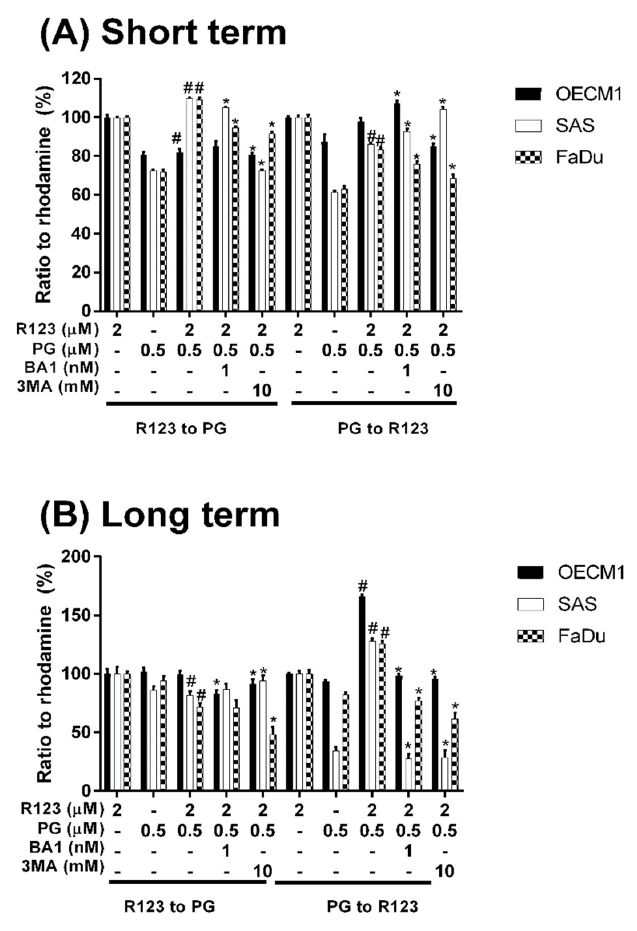
Figure 5. Rhodamine 123 accumulation after PG pretreatment. OSCC cells were treated with PG/R123 for ( A ) short term (1/1 h) and ( B ) long term (12/1 h) followed by analyzed fluorescent intensity within cells. The results were represented as mean ± SD from three individual experiments. # p < 0.05 as compared with R123 alone; * p < 0.05 compared with PG/R123